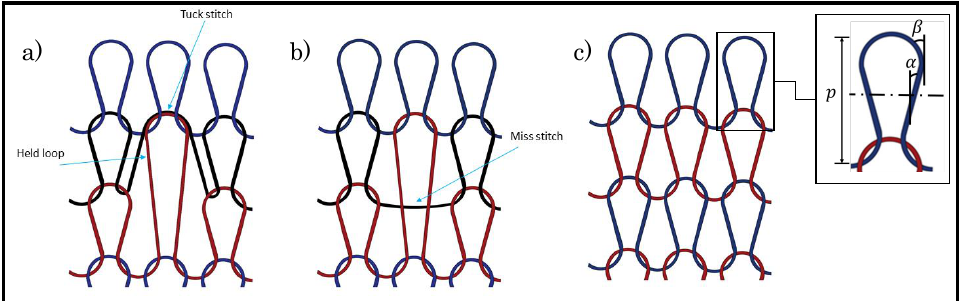
Figure 1. Types of loop stitches. ( a ) Tuck loop stitch, ( b ) Miss stitch, ( c ) Knitted loop stitch. The held loop is the knitted loop stitch tucked by a tuck stitch. p is the course spacing, α and β are the loop and interlocking angles,